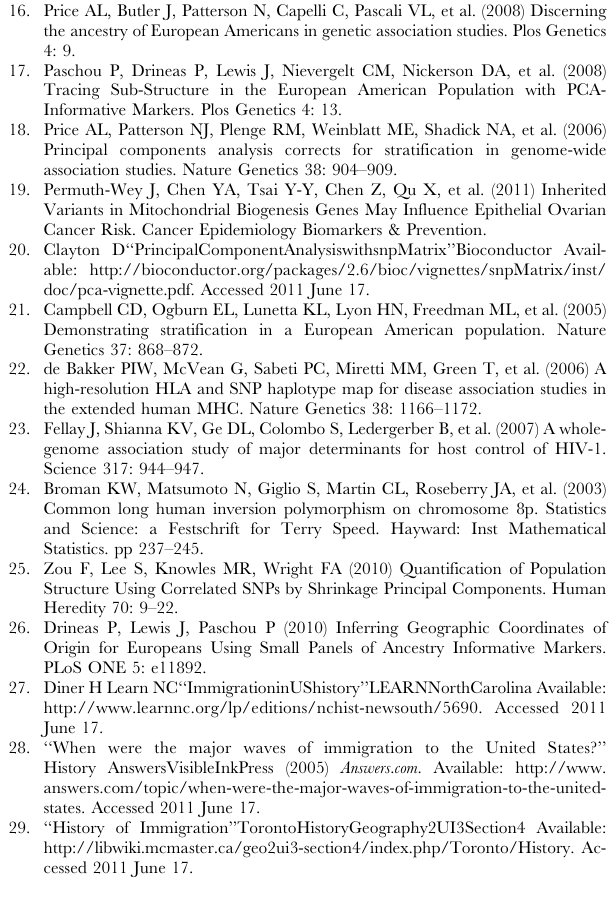
Figure S1 Screeplots for Paschou et al. AIMs PCA and GWAS PCA. Figure S2 Association to site of first 100 PCs in GWAS PCA. P-values for each pair-wise comparison among the four sites are given.